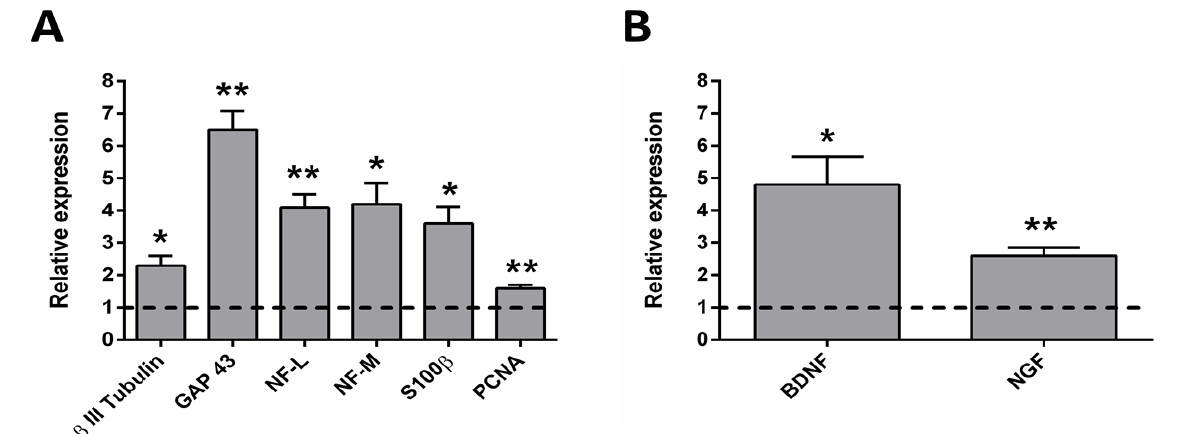
Figure 8. Relative expression levels of the genes studied by RT-qPCR. ( A ) Chicken genes related with axonal growth ( β III Tubulin, GAP 43, neurofilament low chain (NF-L) and neurofilament medium chain (NF-M)), with Schwann cells (S100 β ) and with cell proliferation (PCNA), normalized to chicken GAPDH. ( B ) Rat genes related with brain-derived neurotrophic factor (BDNF) and nerve growth factor (NGF), normalized to rat GAPDH. Statistically significant differences are indicated by * or **, indicating a p -value below 0.05 or 0.01, respectively.